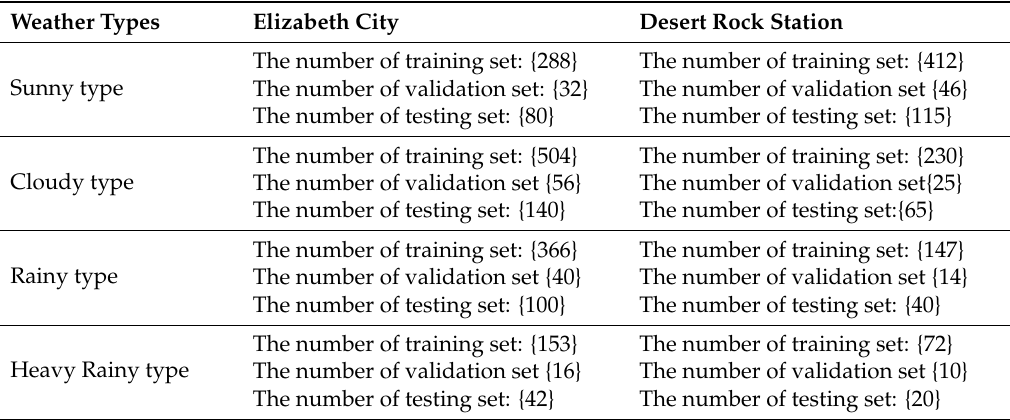
Table 1. The division detail of samples sets under four general weather